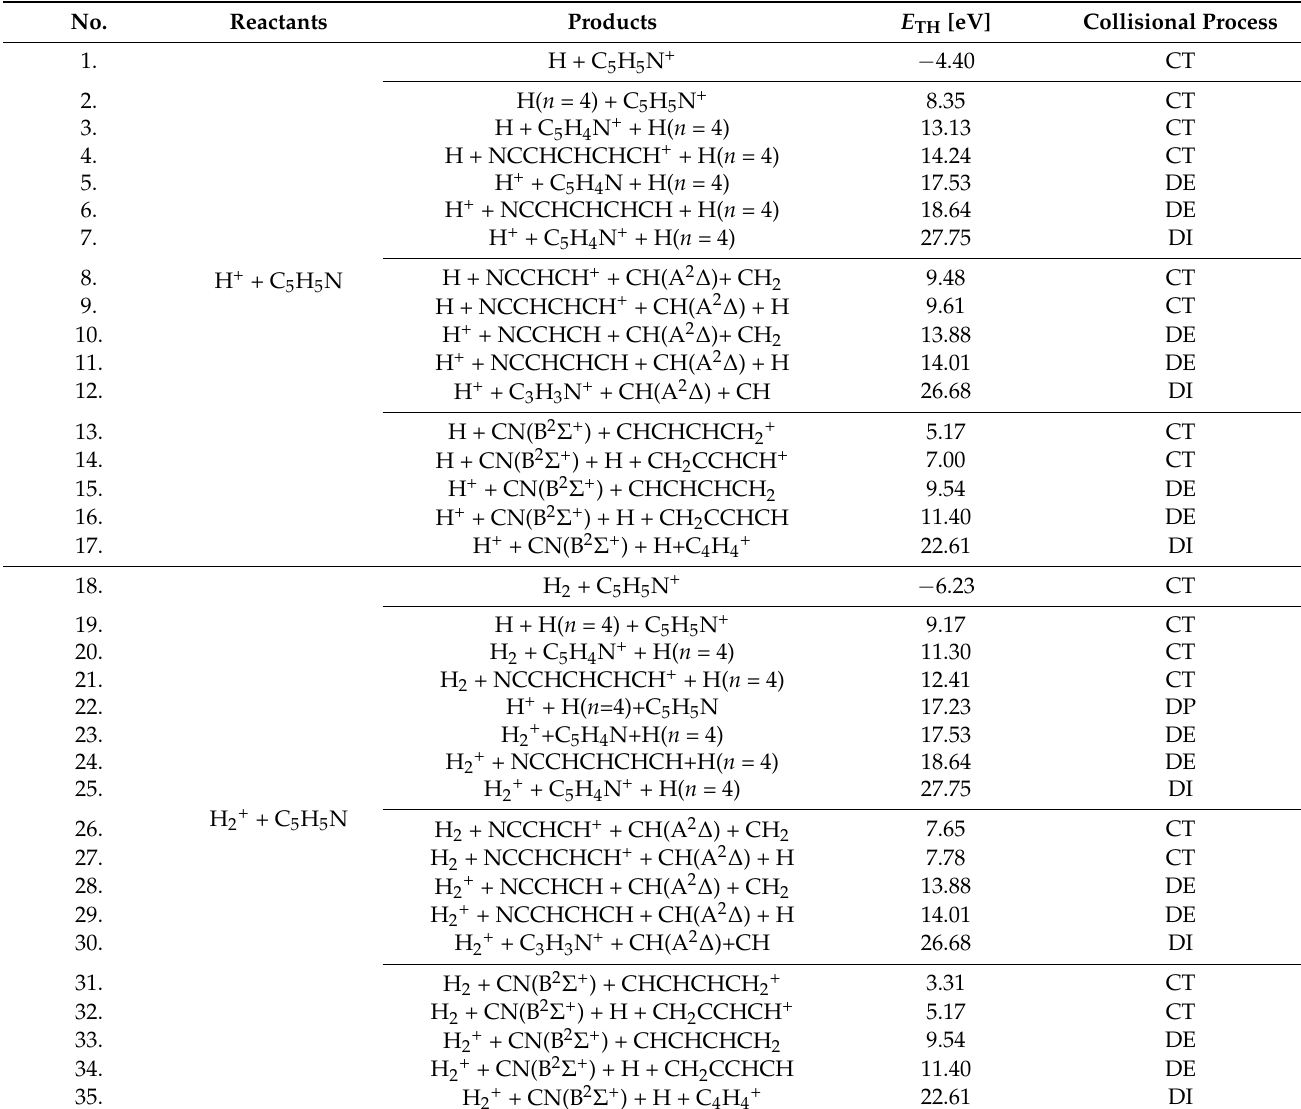
Table 3. Simple thermochemical estimation of the lowest threshold energies ( E TH ) for reactions producing the most intense excited fragments in the collisions of H + /H 2+ with pyridine. Reactants are assumed in their ground states. Note that CT—charge-transfer, DE—dissociative